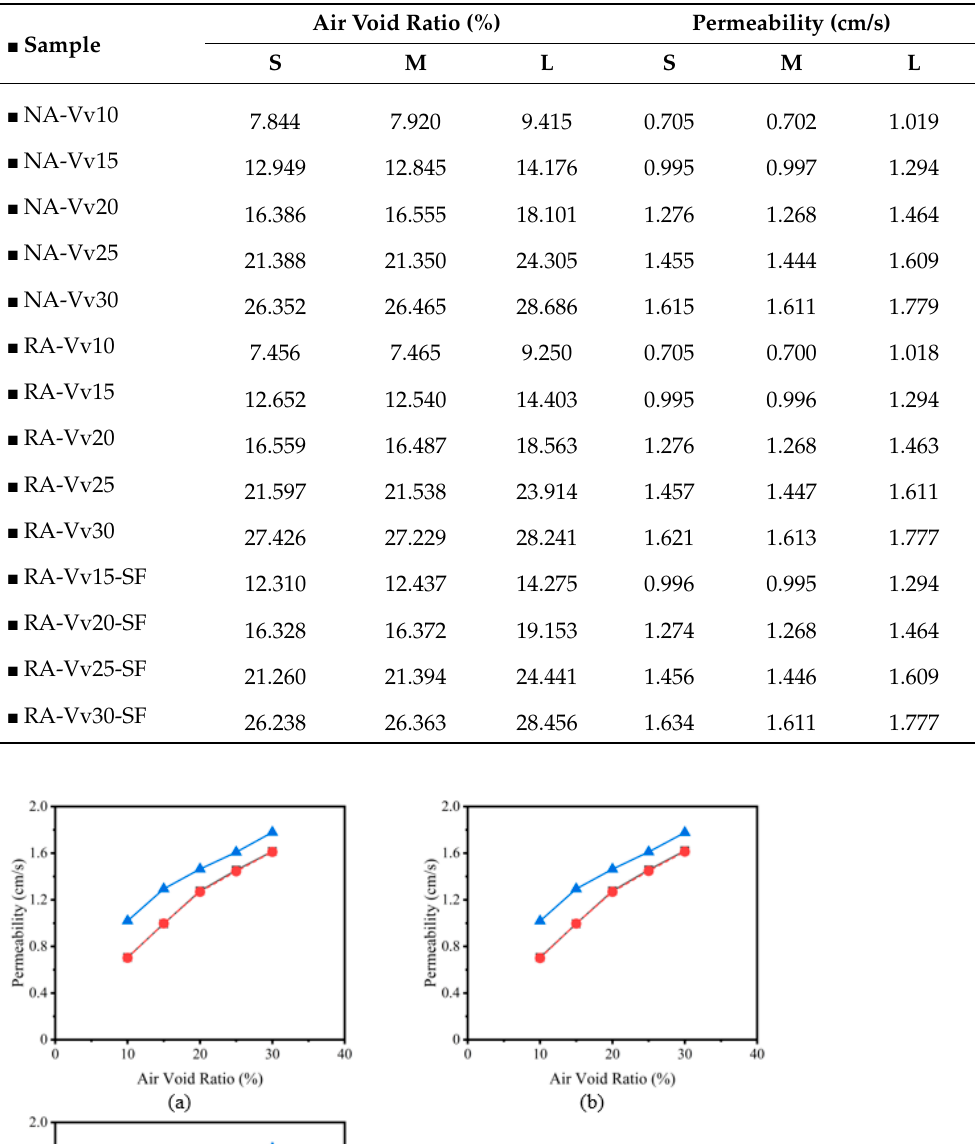
Table 6. Unit weight and water absorption characteristics of natural and recycled aggregates.